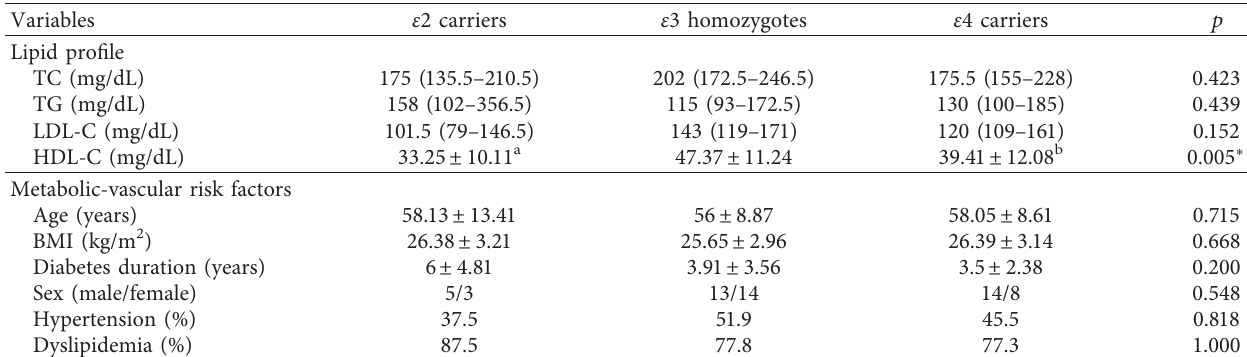
Table 3: Association of apolipoprotein E gene polymorphism with lipid levels and other metabolic-vascular risk factors.